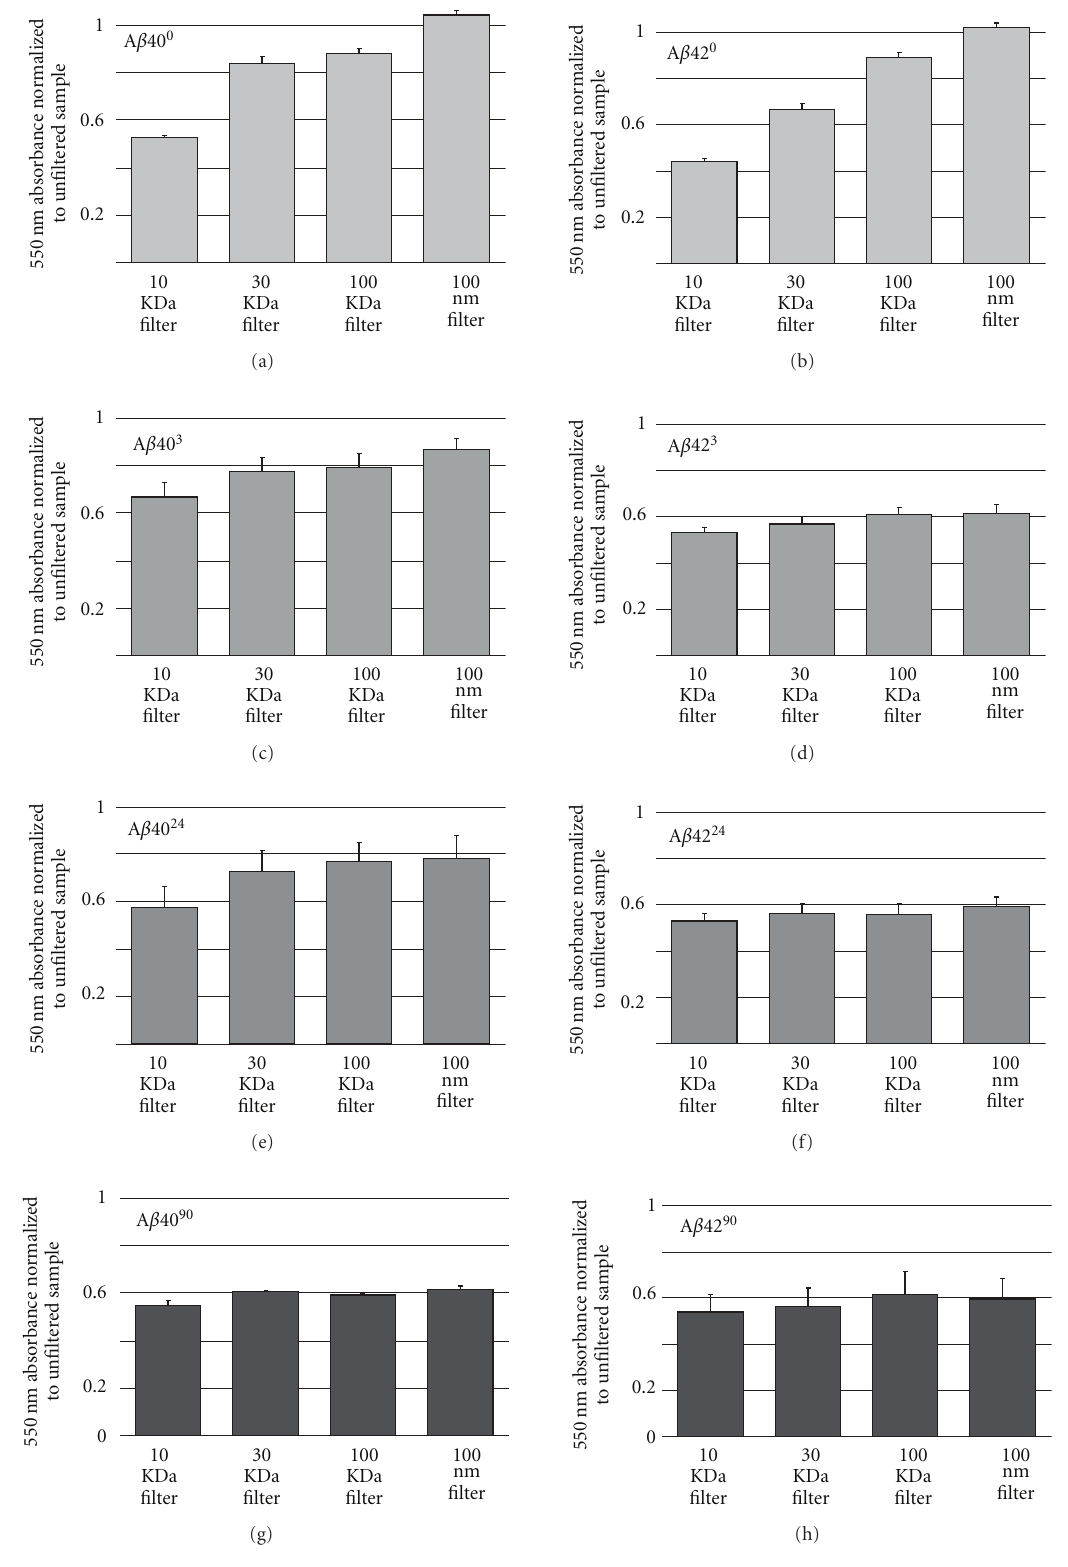
Figure 2: Separation of A β by ultrafiltration. Graphs show the TMR absorbance of the filtrates for each A β sample divided by the absorbance of the unfiltered sample at 550nm. Error bars represent the range from two independent